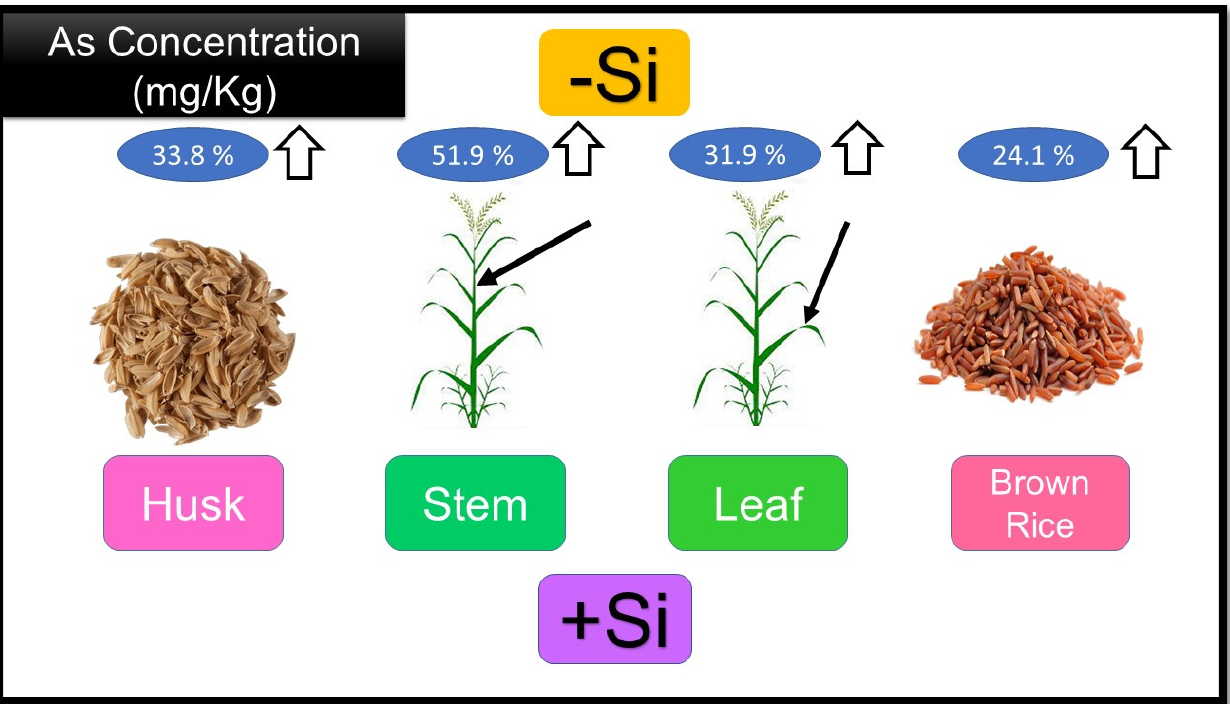
Figure 2. The effect of Adding silicon (+Si) and without silicon ( − Si) treatments on arsenic concentration on different rice tissue. Nomenclature is as proposed by Gang, ZHENG [46].